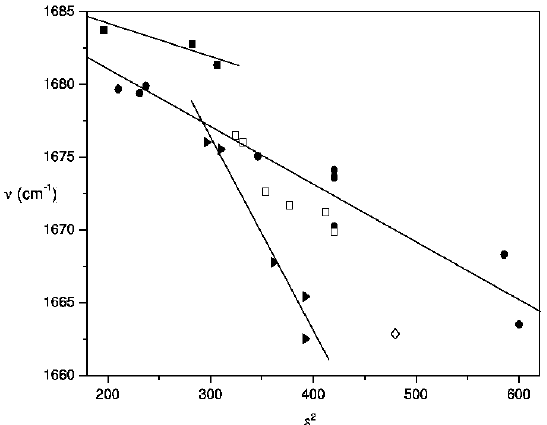
Figure 5. Trends of the frequency of carbonyl band of acetylferrocene with the density cohesive energy density ( 2 δ ). Solvent family designations are as follows: aprotic nonpolar, dipolar, and highly dipolar solvents ( ● ); polychloroalkanes ( ► ), aromatics ( □ ), pyridine ( ◊ ) and alkanes ( ■